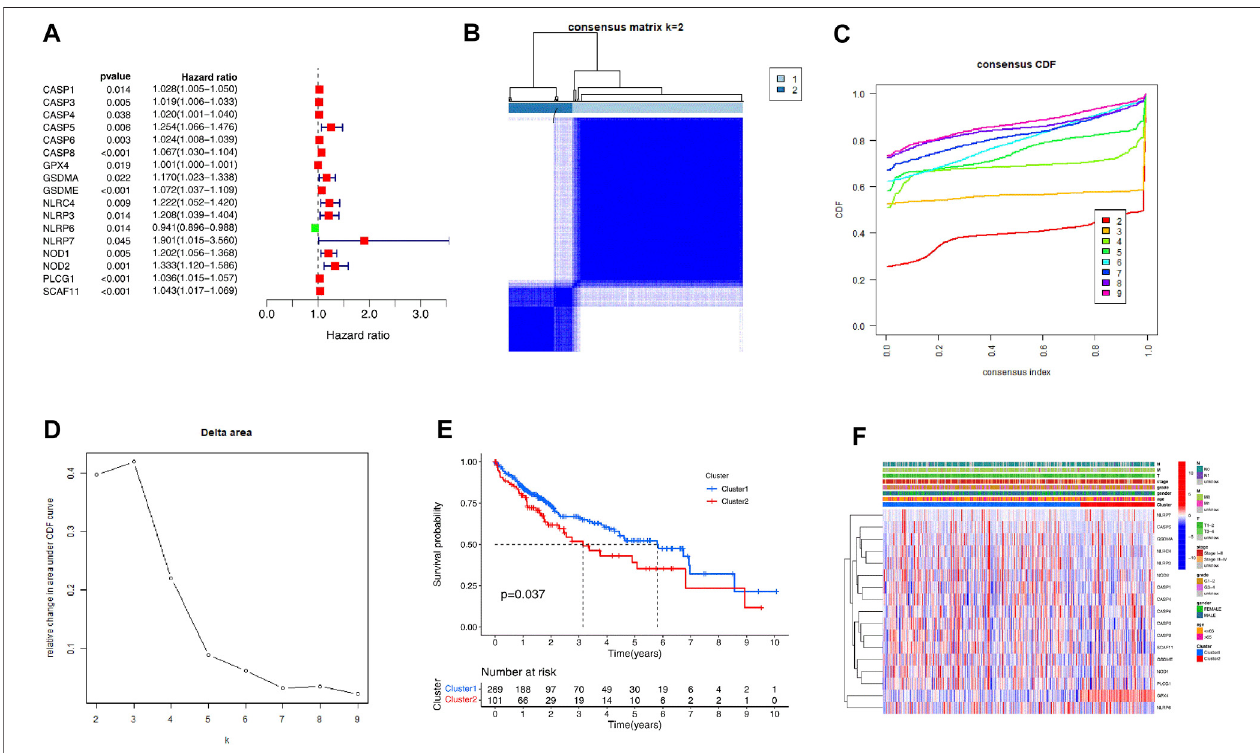
FIGURE 2 | Identi fi cation of the molecular subtypes of the HCC patients using the PRGs associated with prognosis. (A) The univariate Cox Regression Analysis basedforest plotin PRGs. (B) TheHCC patients werestrati fi ed into2clustersbased ontheconsensus clusteringmatrix(k (cid:1) 2). (C, D) Consensus clusteringmodel with cumulativedistributionfunction(CDF)bykfrom2to9. (E) TheKaplan — Meiercurves(KM)oftheoverallsurvivalinthetwoHCCclusters. (F) Heatmapwiththecorrelation between the two groups and their clinicopathologic characters.